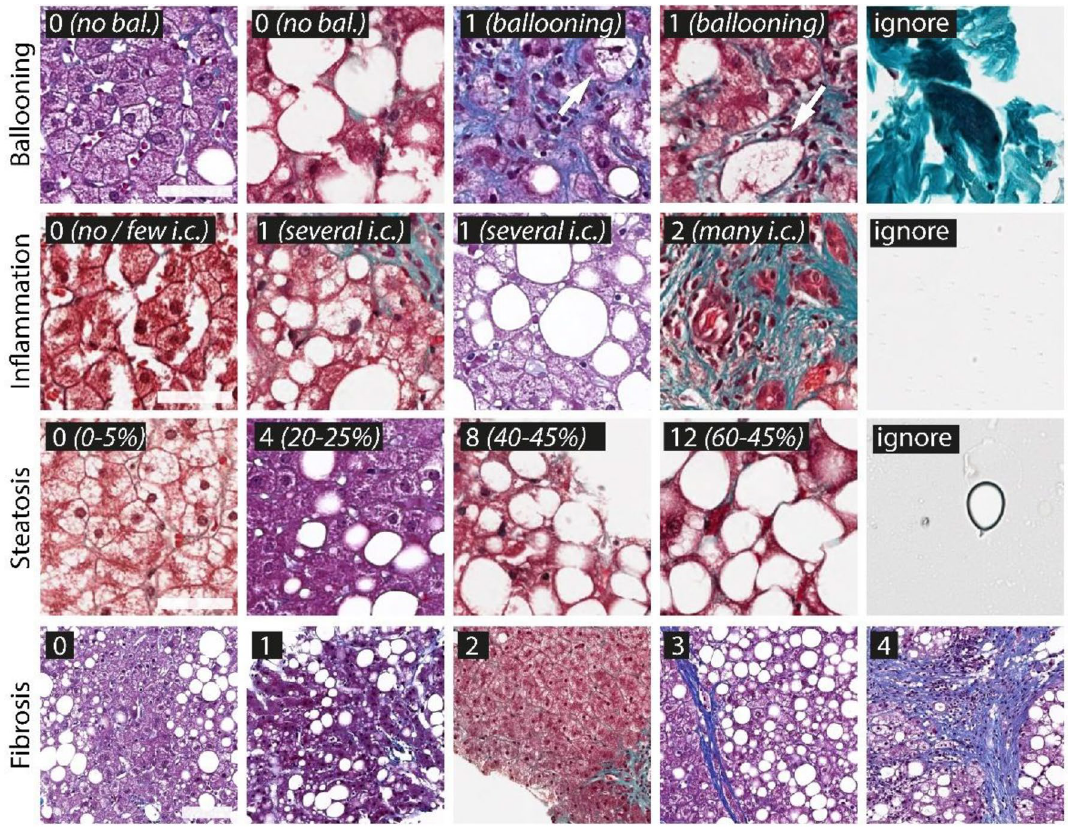
Figure 2. Overview of the training classes of the four CNN models. Models are shown in rows and examples of the classes shown in columns. Class descriptions are shown on the top left of the tiles. For ballooning classes ‘0’ and ‘1’ were defined, with ‘0’ defined by the absence of a ballooning cell and ‘1’ by the presence of a ballooning hepatocyte (arrows). In case of inflammation, classes ‘0’, ‘1’ and ‘2’ were defined depending on the density and morphology of inflammatory cells visible on a tile. For steatosis, class bins of a width of 5% were defined (not all classes shown). For fibrosis the classes per tile corresponded to the macroscopic definition of the fibrosis scores. Each model contained an ignore class to identify artifacts or any kind of non-liver structure (not shown for fibrosis). Scale bars first of three rows (‘high resolution tiles’): 50 µm, scale bar of last row (‘low resolution tiles’): 100